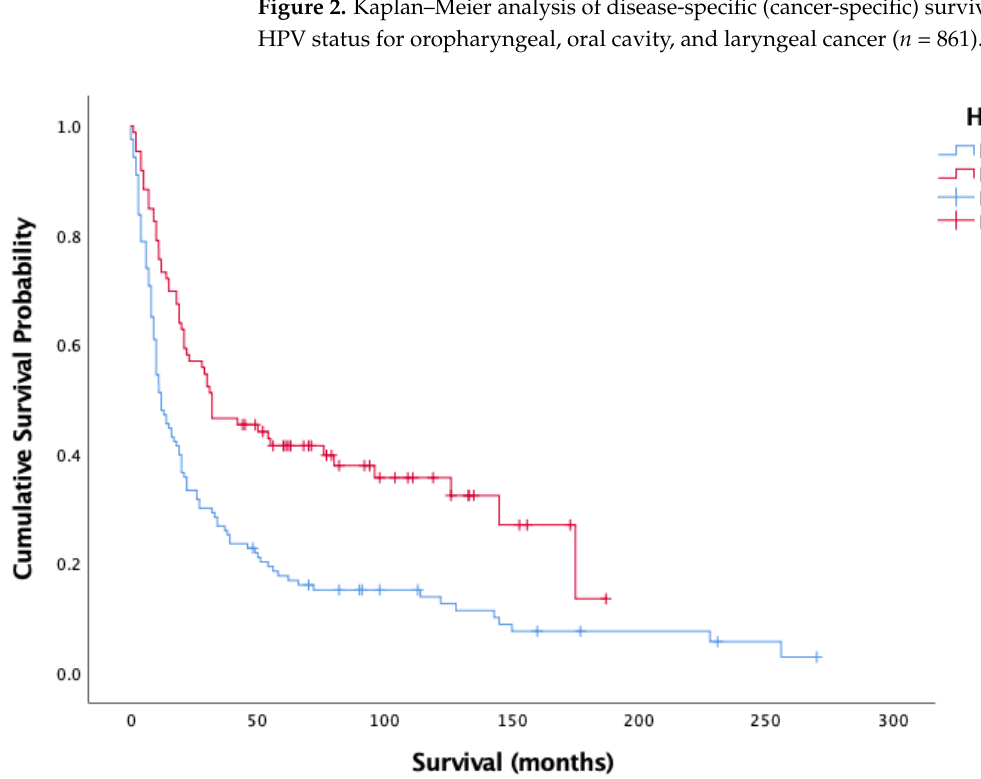
Figure 3. Kaplan – Meier analysis of overall survival in months based on HR HPV status for oropha- ryngeal cancer (n = 209).